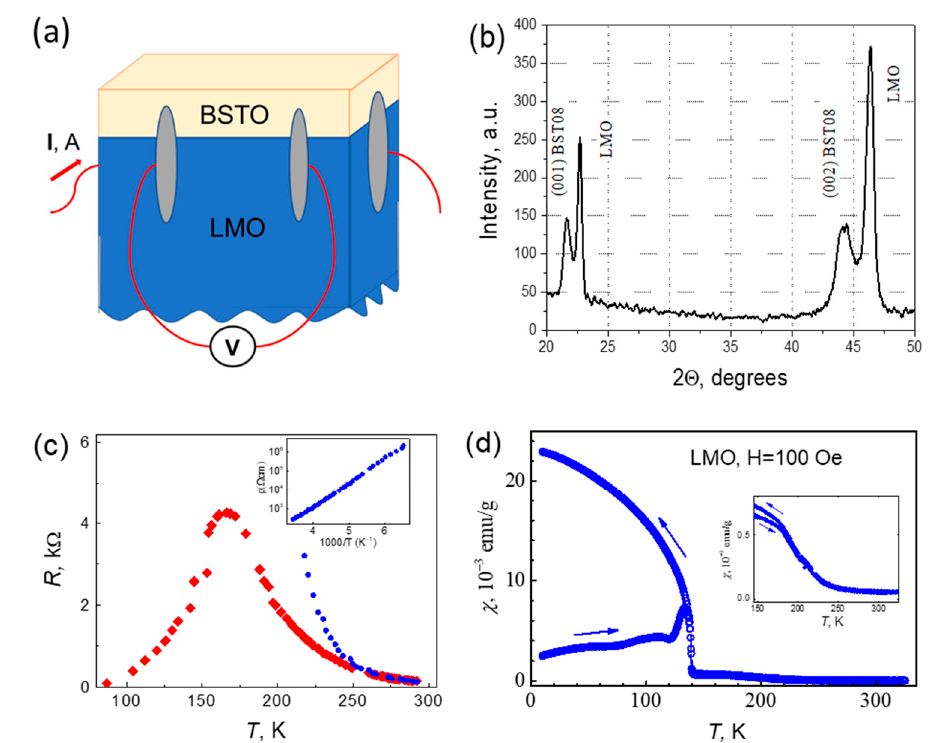
Figure 7. ( a ) The scheme of the electrical resistance measurements with the red color schematically showing the placement of the contacts with grey silver paste and the current and measuring wires; ( b ) the X-ray diffraction pattern of the heterostructure; ( c ) the temperature dependence of the resis- tivity for the Ba 0 . 8 Sr 0 . 2 TiO 3 /LaMnO 3 heterostructure is shown, the insert shows the temperature de- pendence of the resistivity for LaMnO 3 single crystal in the inverse temperature; ( d ) the temperature dependence of magnetic susceptibility for the Ba 0 . 8 Sr 0 . 2 TiO 3 /LaMnO 3 heterostructure. The zoom of the temperature dependence of the magnetic susceptibility in the vicinity of phase transition is shown in the insert.